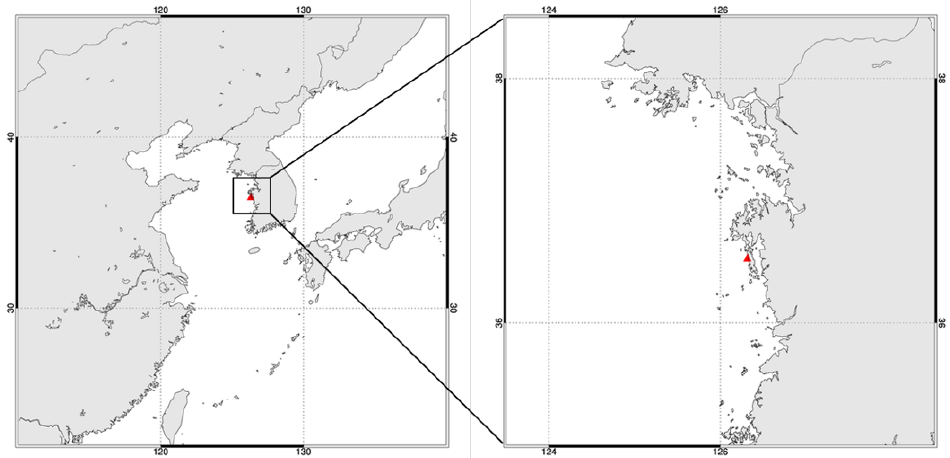
Figure 1. The location of Anmyeondo station (AMY, 36.53° N, 126.32° E), South Korea (represented as a red triangle), where Atmospheric Emitted Radiance Interferometer (AERI) was installed.